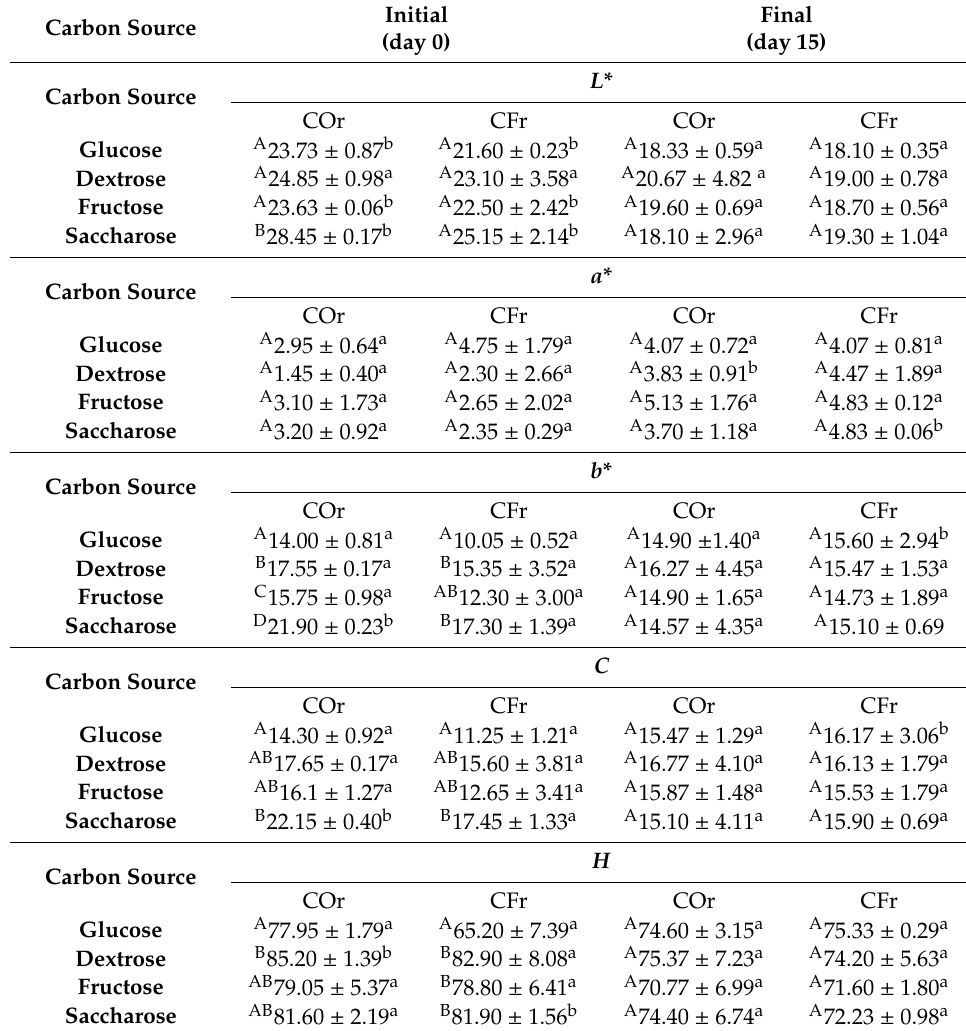
Table 2. Color determinations of kombucha fermentations with various carbon sources stored at 25 ◦ C for 15